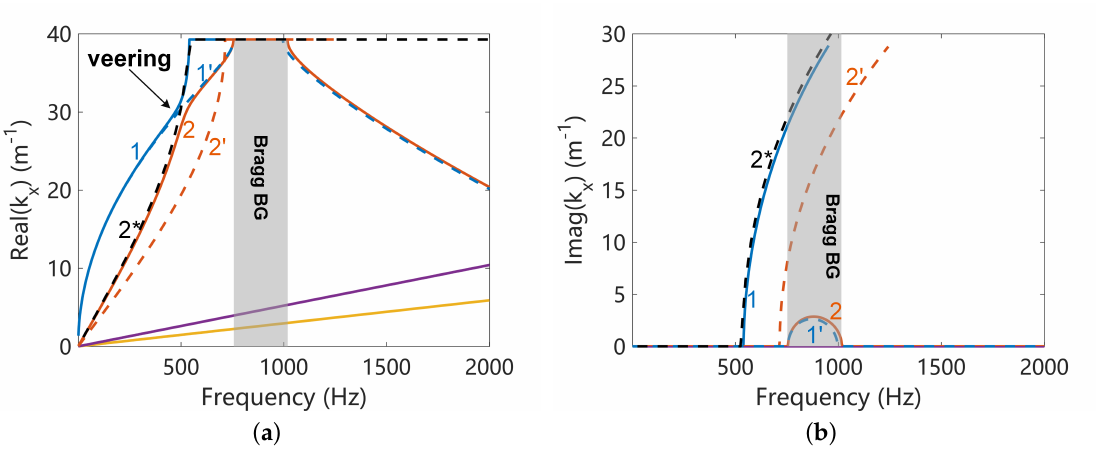
Figure 14. Dispersion curves along the x direction of L-network with L = 0.5 H, ( a ) shows the real part of k x and ( b ) shows the imaginary part of k x . Waves 1 and 2 are electromechanical waves; 3 and 4 are respectively shear wave and longitudinal wave. The dash lines 1’ and 2* refer to uncoupled disconnected flexural and electric waves respectively. The dash line 2’ refers to the uncoupled blocked electric